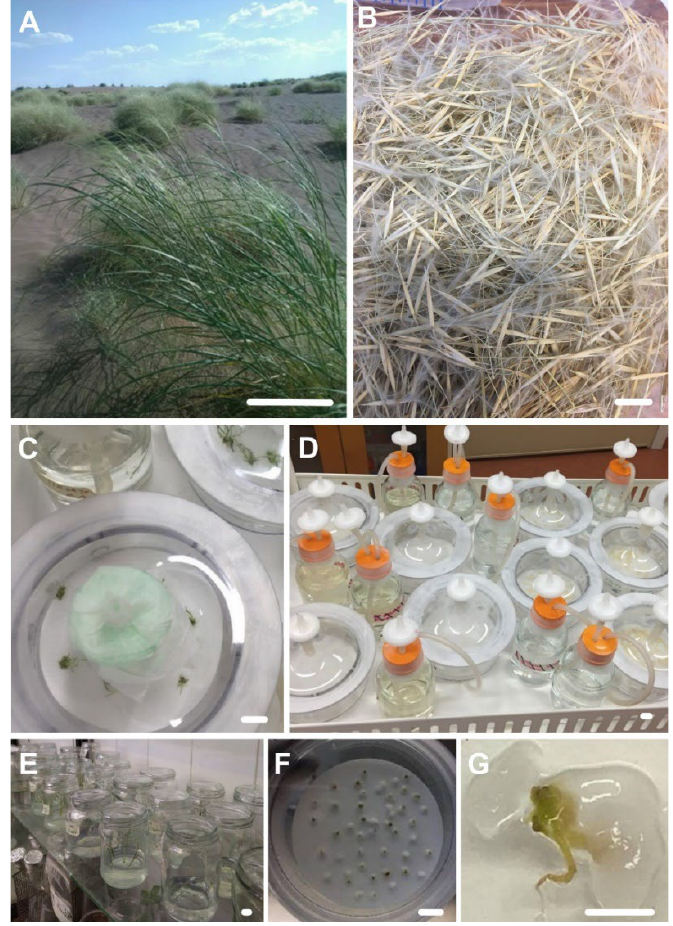
Figure 1. ( A ) S. pennata in the desert habitat. ( B ) Seeds of wild growing plants. ( C ) Temporary immersion bioreactor system with germinated artificial seeds. ( D ) Temporary immersion bioreactor (TIB) system. ( E ) Shoot growth in solid media. ( F ) Artificial seeds of S. pennata . ( G ) Germinated artificial seed of S. pennata . Scale bar: ( A ) is 10 cm; ( B – G ) is 1 cm.